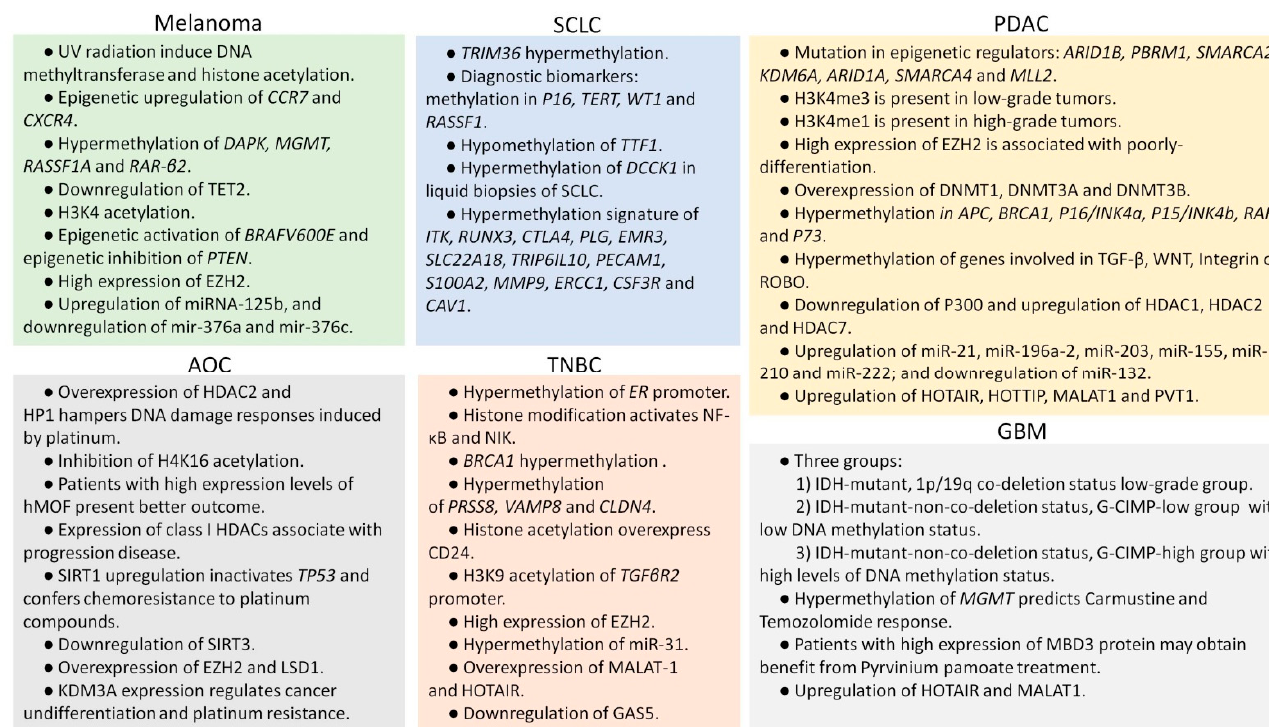
Figure 4. Summary of the most representative epigenetic modifications of most aggressive solid tumors observed in adulthood. UV: ultraviolet. SCLC: small-cell lung cancer. PDAC: pancreatic ductal adenocarcinoma. AOC: advanced ovarian cancer. TNBC: triple-negative breast cancer. GBM: glioblastoma.